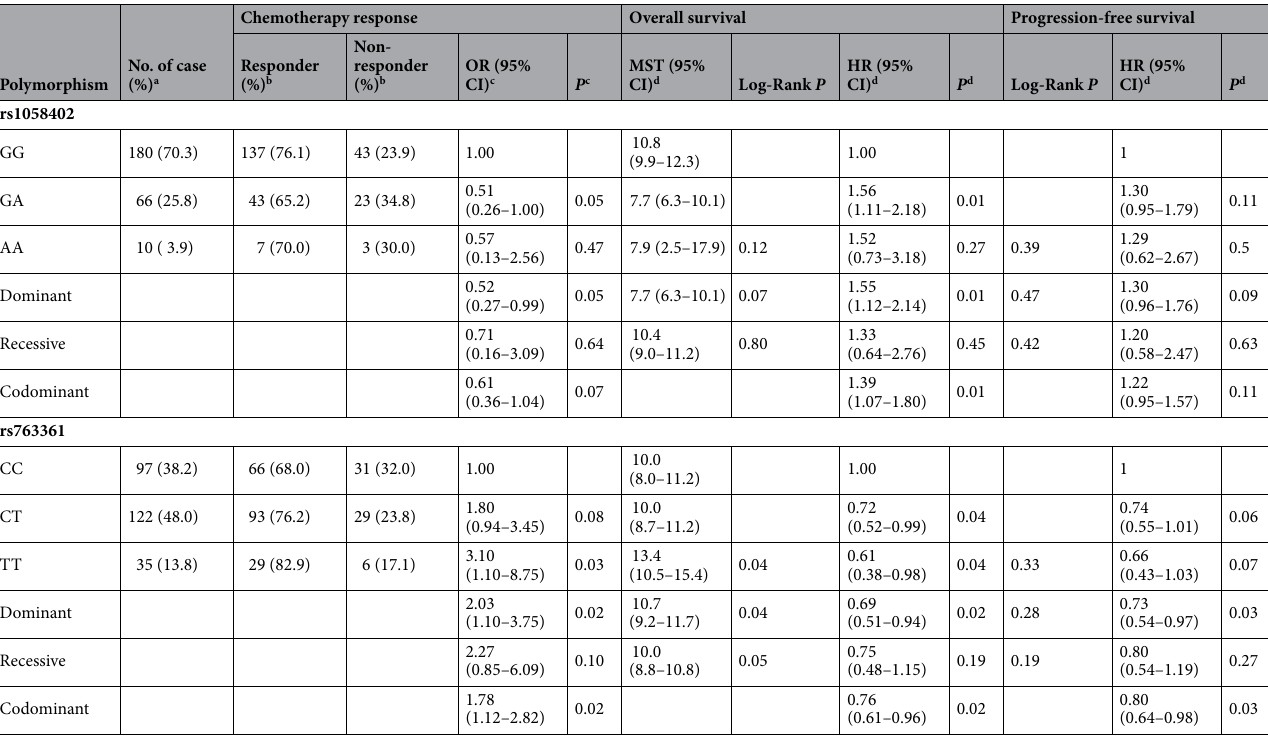
Table 2. Chemotherapy response and survival outcomes according to CD155 rs1058402 and CD226 rs763361 genotypes. OR, odds ratio; CI, confidence interval; MST, median survival time (months); HR, hazard ratio. a Column percentage. b Row percentage. c OR, 95% CI, and their corresponding P -values were calculated by multivariate regression analysis, adjusted for age, gender, smoking status, stage, Eastern Cooperative Oncology Group performance status, weight loss, neuron specific enolase level, and first chemotherapy regimen. d HR, 95% CI and their corresponding P -values were calculated using multivariate Cox proportional hazard models, adjusted for age, gender, smoking status, stage, Eastern Cooperative Oncology Group performance status, weight loss, neuron specific enolase level, first chemotherapy regimen, second line chemotherapy, and radiation to primary tumor.